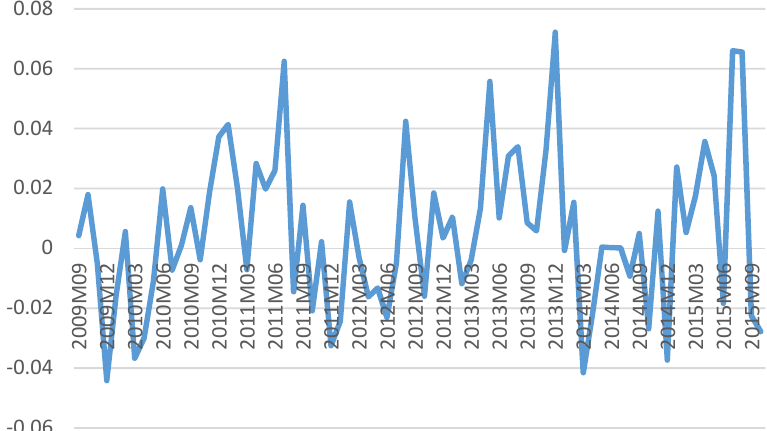
Figure 1. Volatility in the value of the Lira against the Euro (percentage change compared to previous month).